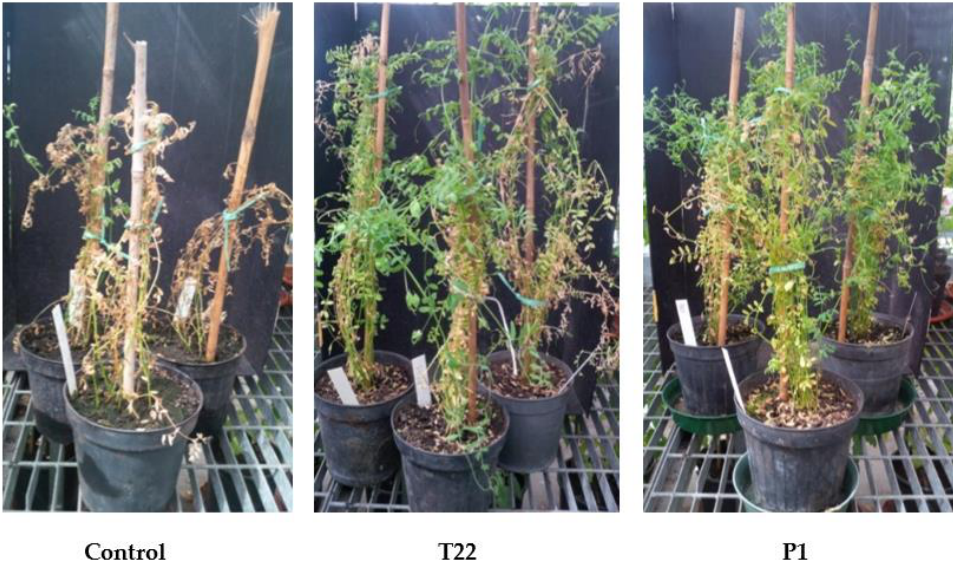
Figure 1. Development of lentil plants treated with various Trichoderma strains. ( Left ) Control (water) untreated. ( Center ) Plants treated with T. afroharzianum strain T22. ( Right ) Plants treated with the strain P1 of T. atroviride .